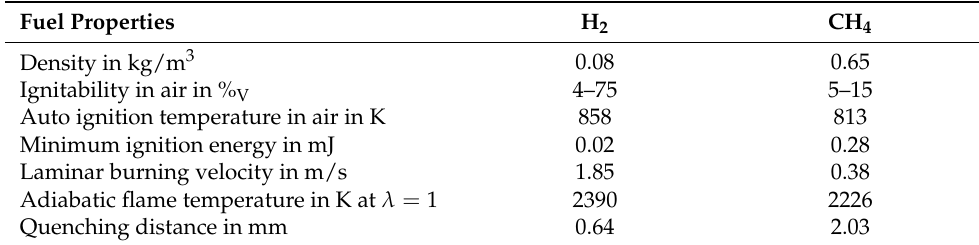
Table 1. Fuel properties under normal conditions (cf. [16].)